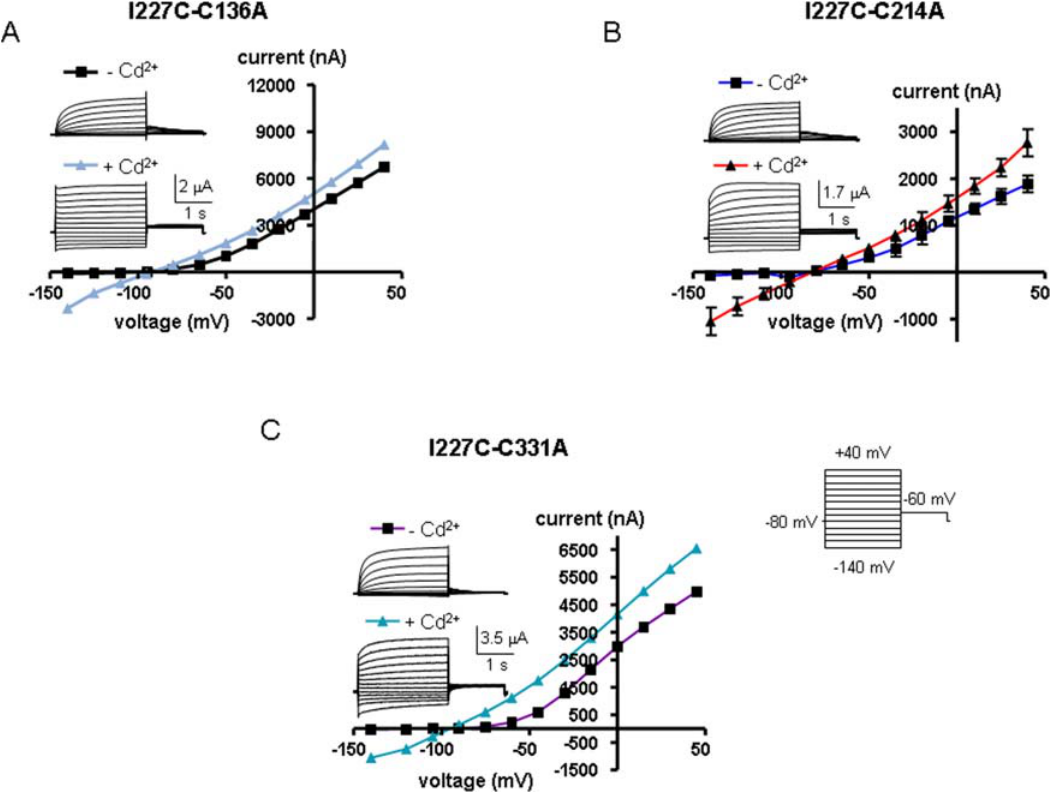
Figure 5. Effects of external Cd 2 + on the double mutants I227C-C136A (A), I227C-C214A (B) and I227C-C331A (C). Oocytes were bathed in ND96 in the absence and presence of 100 m M CdCl 2 . Currents were evoked as in Figure 2. Shown are representative traces and current- voltage relations.